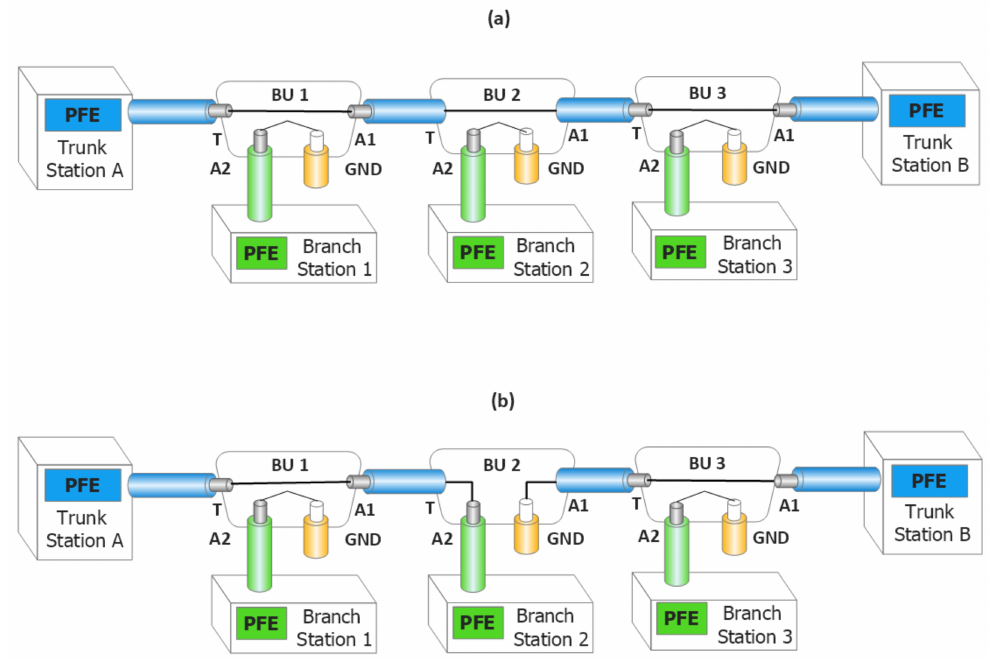
Figure 29. Reconfigurable power switched schemes for BUs. ( a ) Dual-end power feeding on trunk route ( b ) Reconfiguration of dual-end power feeding from one trunk station to the Branch 2